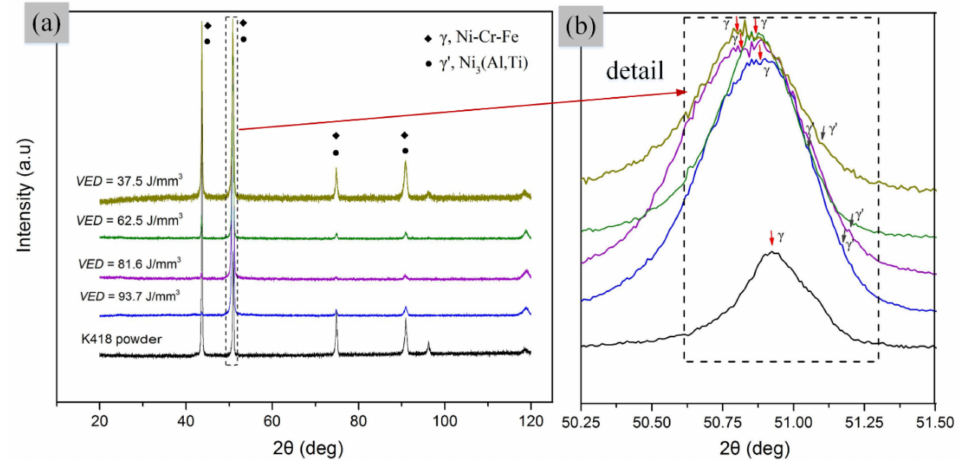
Figure 3. XRD of the LPBF-manufactured K418 with different VED : ( a ) 2 θ = 20–120 ◦ ; ( b ) 2 θ = 50–52 ◦ .